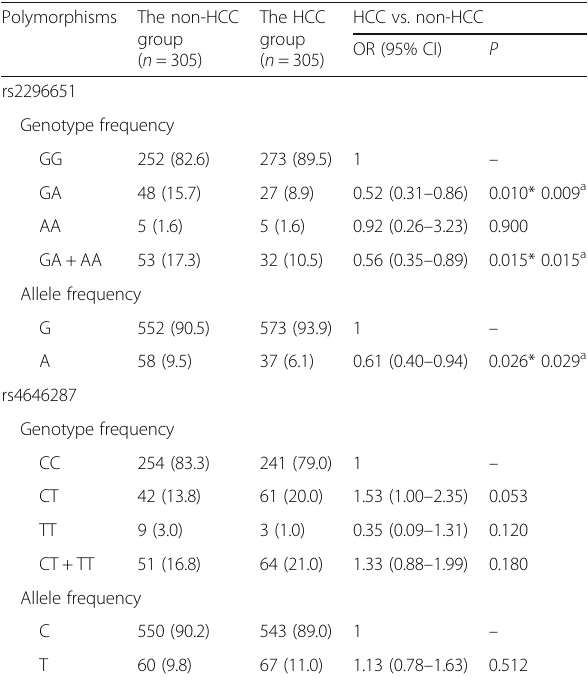
Table 3 Genotype and allele frequencies of the studied SNPs in patients with chronic HBV infection Polymorphisms The non-HCC